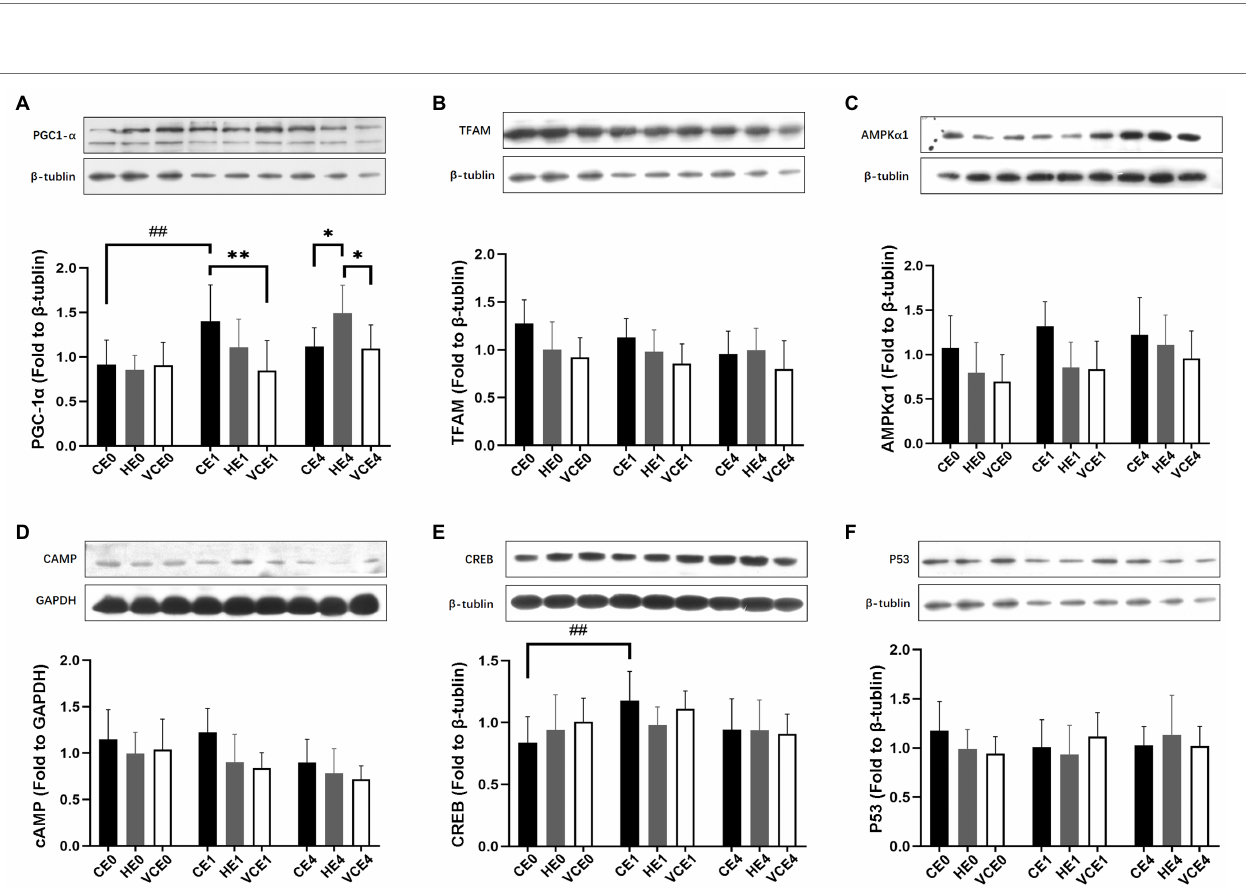
FIGURE 3 | The protein expressions of PGC-1 α (A) , TFAM (B) , AMPK α 1 (C) , cAMP (D) , CREB (E) , and p53 (F) in gastrocnemius muscle, measured by western blot. C, blank control; H, inhalation of hydrogen gas; VC, vitamin C supplementation; E0, baseline; E1, immediately after exercise; and E4, 4 h after exercise. n = 9 per group. * p < 0.05, ** p < 0.01; ## p <